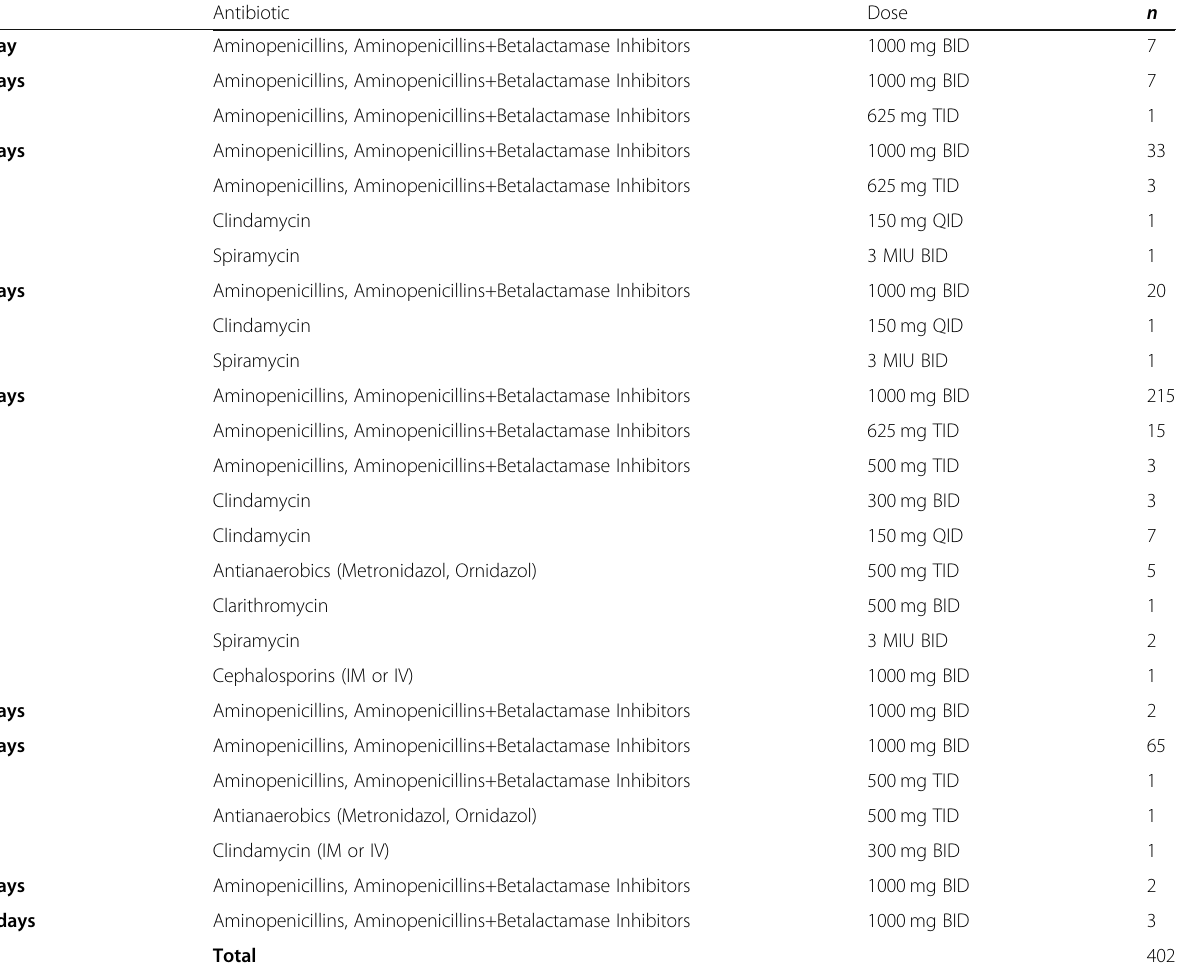
Table 9 Postoperative antibiotics preferred by the clinicians with regimen and dosage For Antibiotic Dose n